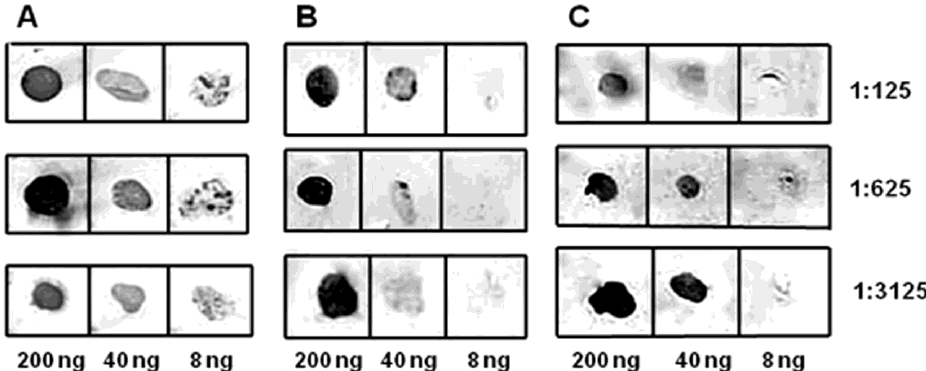
Figure 6. Dot-ELISA of the murine antisera obtained. The dilution ratios for antisera are indicated on the right, while the quantity of used CP BYV epitope is indicated at the bottom of the figure. ( A ) antiserum to ep1 ; ( B ) antiserum to ep2 ; ( C ) antiserum to the mix of ep1 and ep2 .